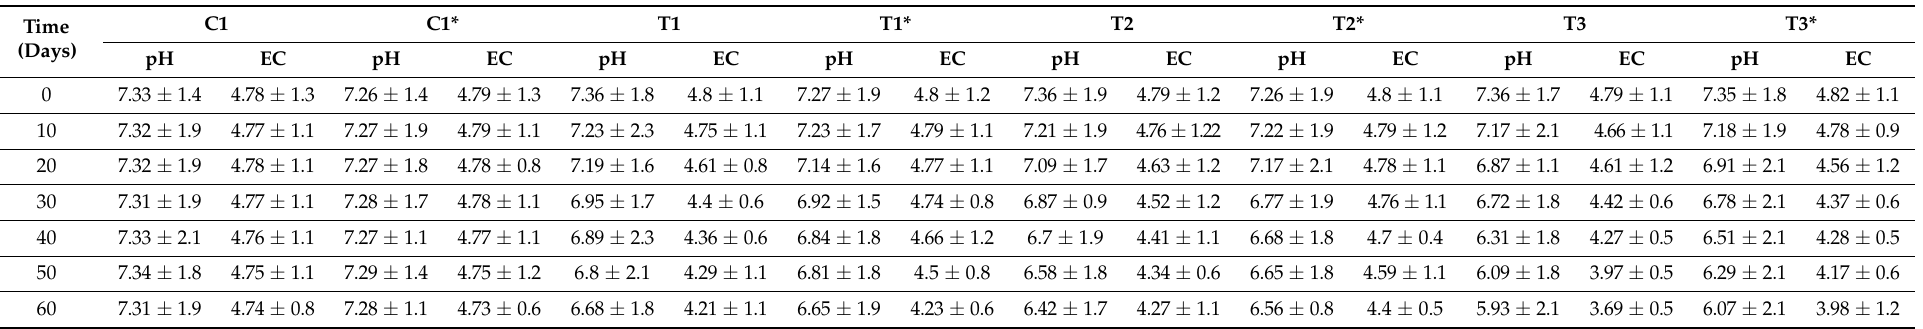
Table 1. Comparison of the changes in pH and EC of phenanthrene-contaminated water treated by FTWs and CWs vegetated with Phragmites australis and amended with a bacterial